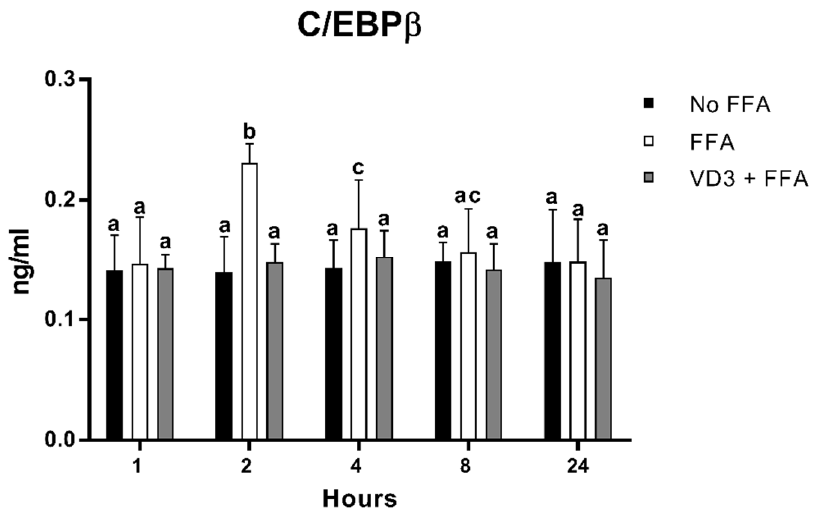
Figure 6. Effect of VD3 supplementation on C/EBP β cell protein levels. Data are reported as mean ± standard deviation. a,b,c Bar graphs with different letters are significantly different ( p ≤ 0.01). No FFA: no free fatty acids (control); FFA: free fatty acids (500 μ M); VD3: calcitriol (50 nM).